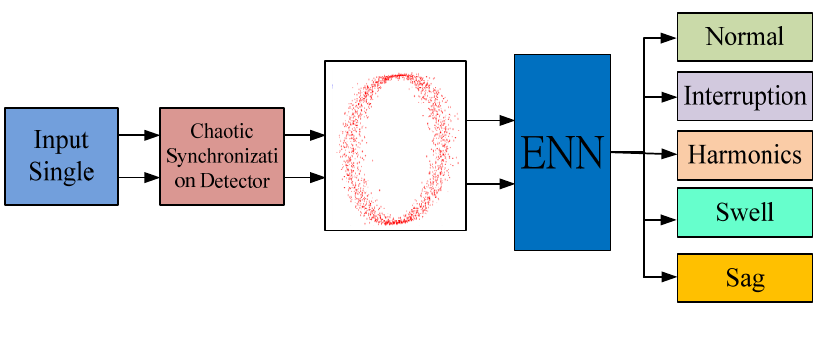
Figure 1. Proposed power quality detection